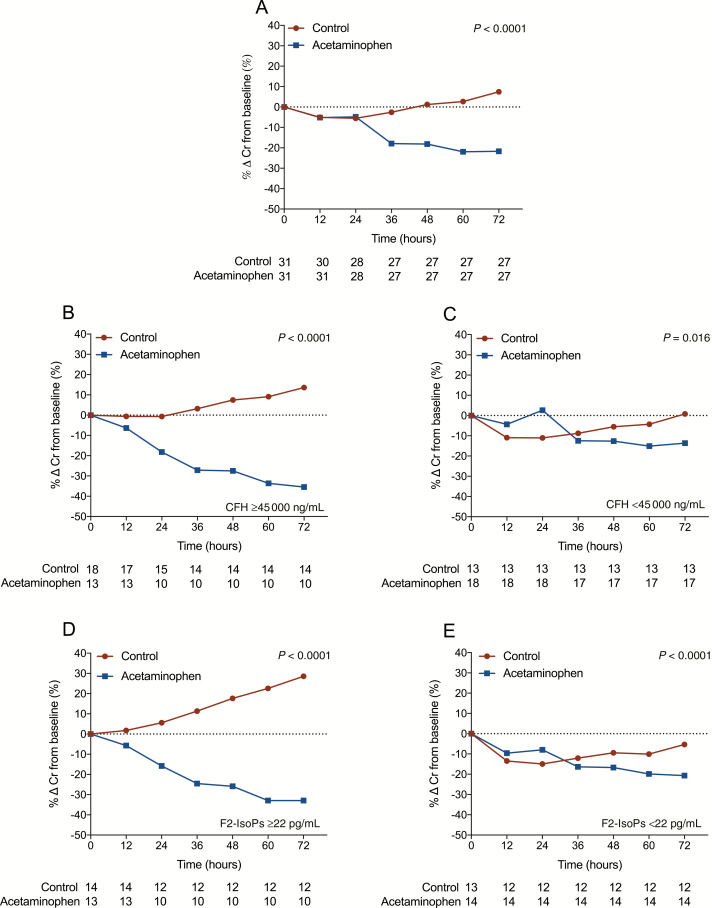
Effect of acetaminophen on creatinine stratified by intravascular hemolysis. Creatinine mean percent change from baseline at 12, 24, 36, 60, 48, and 72 hours of entire cohort (A) and patients stratified by level of intravascular hemolysis (B and C). Plasma cell-free hemoglobin (CFH) ≥45000 ng/mL (B); plasma CFH <45000 ng/mL (C); patients stratified by level of lipid peroxidation (D and E); plasma F2- isoprostanes (IsoPs) ≥22 pg/mL (D); plasma F2-IsoPs <22 pg/mL (E). A total of 35 of 434 (8%) creatinine sampling time points were missing and replaced by imputed values (for details see Supplementary Table 2). Frequencies in rows below figures represent number of patients (n) at each time point. P value represents overall treatment effect. Abbreviations: Cr, creatinine; CFH, cell-free hemoglobin; F2-IsoPs, F2-isoprostanes.